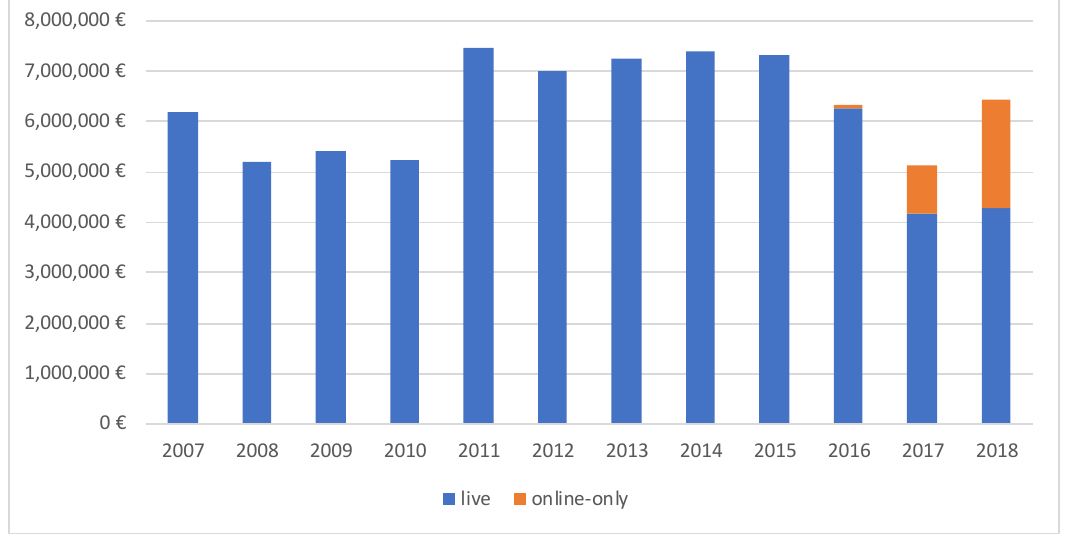
Figure 6. Total number of lots taken to auction (live and online-only) (2007 – 2018).